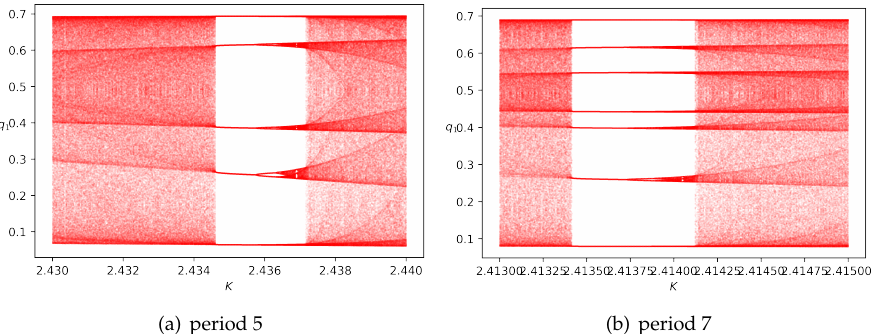
Figure 4. Periodic orbits of odd orders found in the bifurcation diagrams of the iteration map (3) with respect to K against q 1 if fixing the parameters c 1 = 0.5, c 2 = 1.0 and setting the initial state as ( x ( 0 ) , y ( 0 )) = ( 0.5,0.5 ) . An orbit of period 5 can be observed in ( a ), and an orbit of period 7 can be observed in ( b